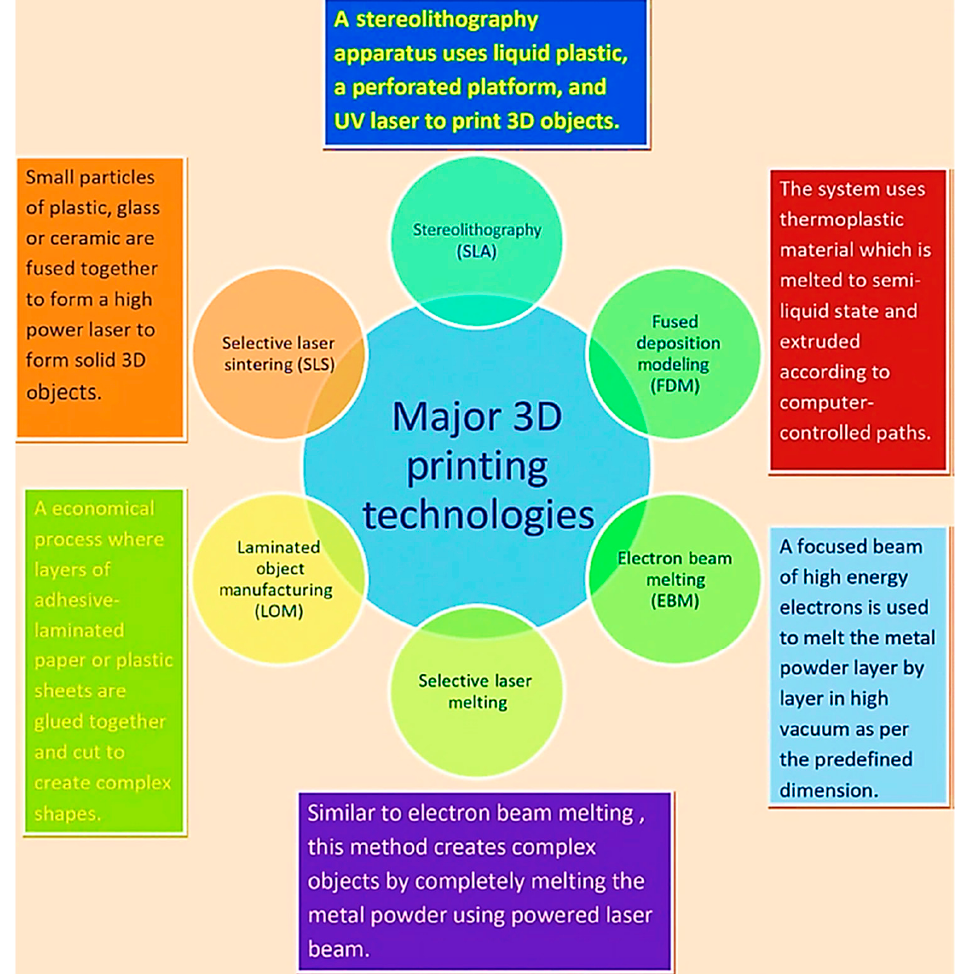
Figure 4. 3D printing technologies [59]. Reproduced with permission from